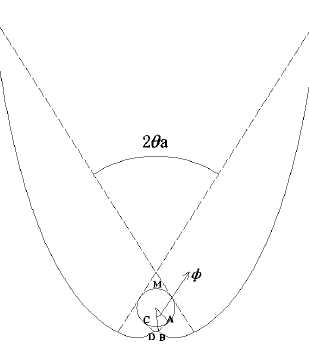
Figure 4. CPC ‐ 3, designed based on inner tube of EST with the involutes near the inner tube being truncated.